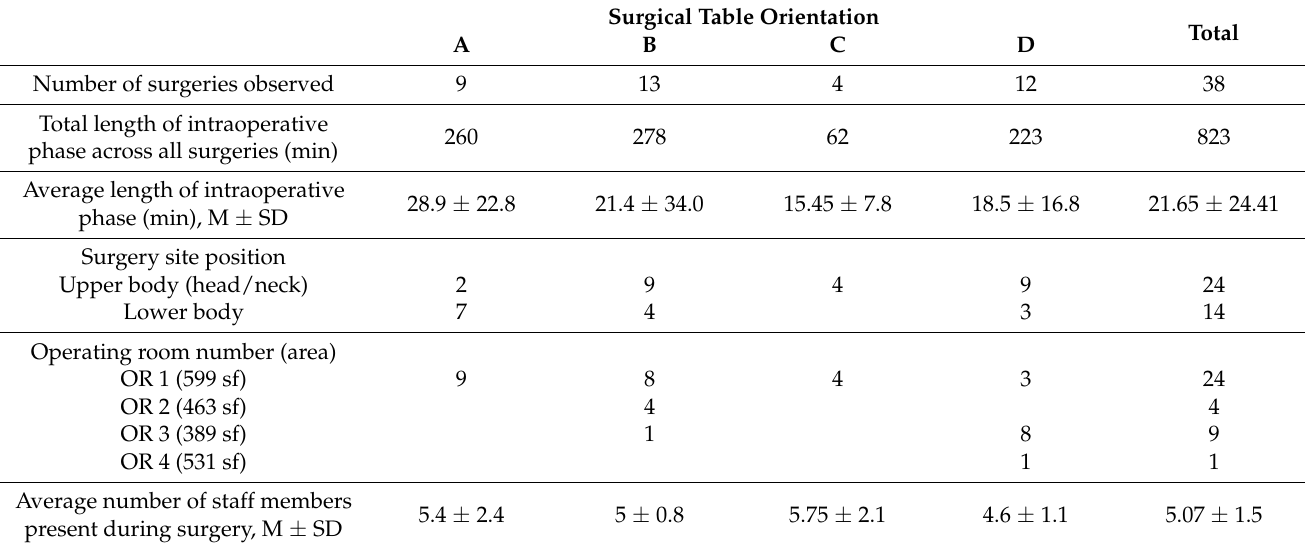
Table 2. Overview of surgeries observed across different surgical table orientations. Surgical Table